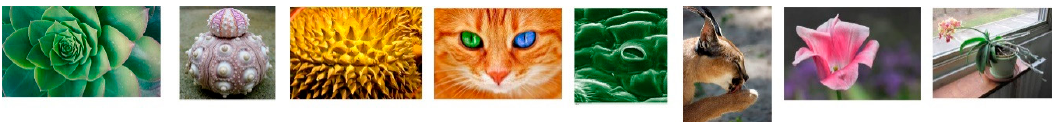
Table 3. A preliminary mapping of several biological systems through the systematic classification.